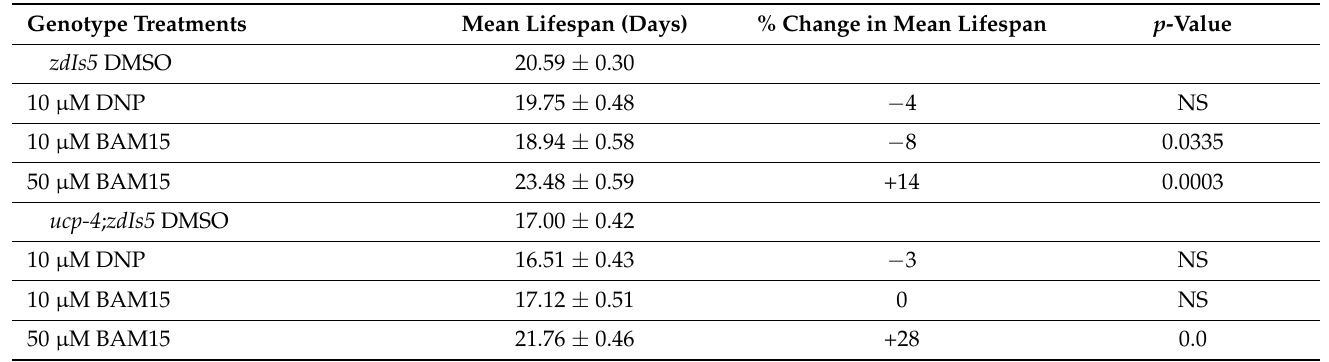
Table 1. Summary of mean lifespan in both zdIs5 and ucp-4 ; zdIs5 treated with 10 µ M DNP, 10 µ M BAM15, and 50 µ M BAM15. The values were derived from the survival curves. n = 248~309 per treatment in each genotype. Log-rank test, p < 0.001 between DMSO and 10 µ M DNP, and DMSO and 50 µ M BAM15 treatments. Data are presented as means of three independent experiments. NS, not statistically